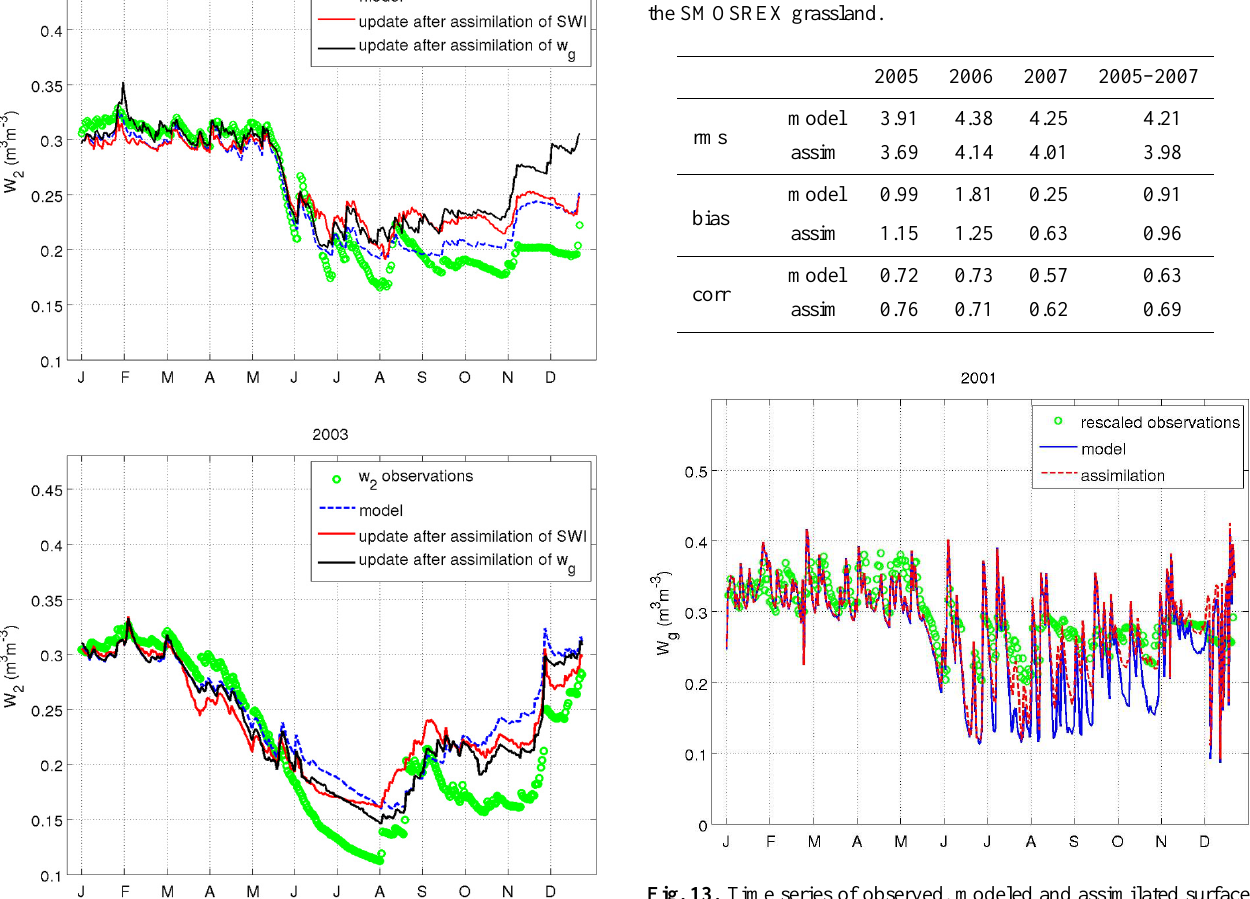
Fig. 12. Time series of root-zone soil moisture before and after assimilation of SWI and w g against w 2 measurements (m 3 m − 3 ) for 2001 (top) and 2003 (bottom), respectively.